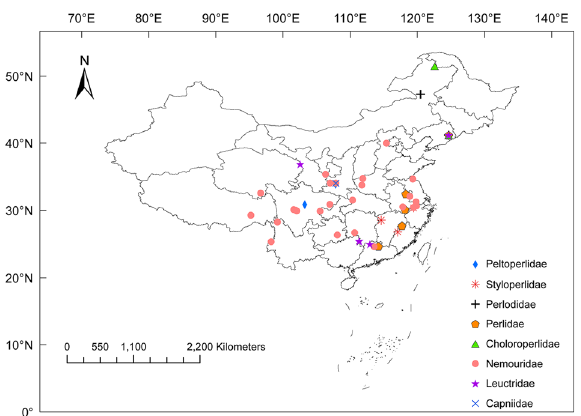
Fig. 1 Sampling locations of wild stone fl ies across multiple geographic regions of China. Differently colored symbols represent different stone fl y families. The fi gure was generated using ArcGIS 10 Crack software based on a template map from the Chinese National Basic Geographic Information Center